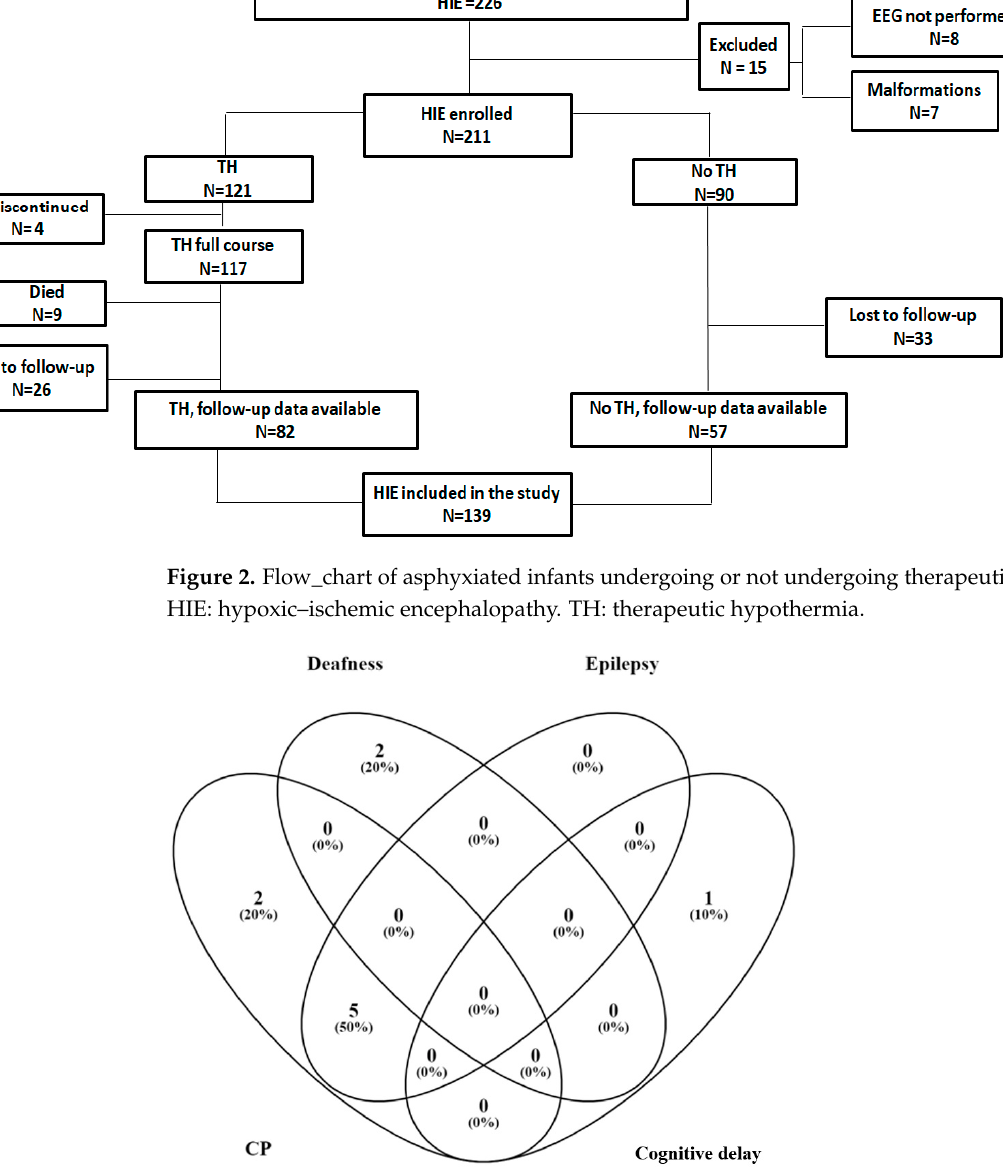
Figure 3. Venn diagram of infants with severe neurodevelopmental outcome. Patients with severe outcome are reported in the Venn diagram. CP: cerebral palsy Table 1. Comparison of cooled and un-cooled asphyxiated infants. All HIE (n = 139)